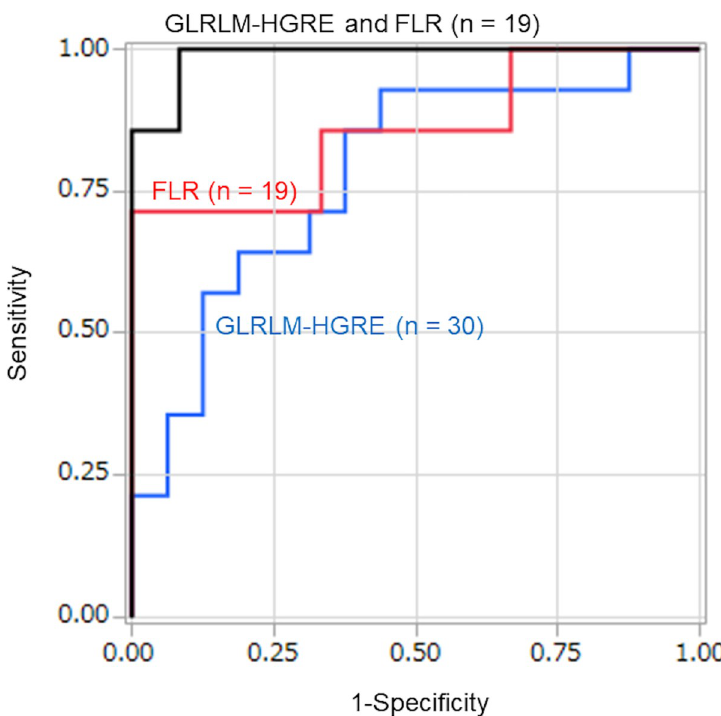
Fig 4. Receiver Operating Characteristic (ROC) curves of the values for CT-based texture features and US elastographic FLRs. ROC curves of the grey-level run length matrix (GLRLM)-high gray-level emphasis (HGRE) feature and the fat-to-lesion strain ratio (FLR), and the ROC of the combination of GLRLM-HGRE and FLR, which shows almost perfect diagnostic accuracy for distinguishing between lymphadenopathy due to sarcoidosis and that due to metastasis from small cell lung cancer. The area-under-the-curve values were as follows: GLRLM-HGRE alone, 0.781; FLR alone, 0.857; combination of GLRLM-HGRE plus FLR, 0.988.